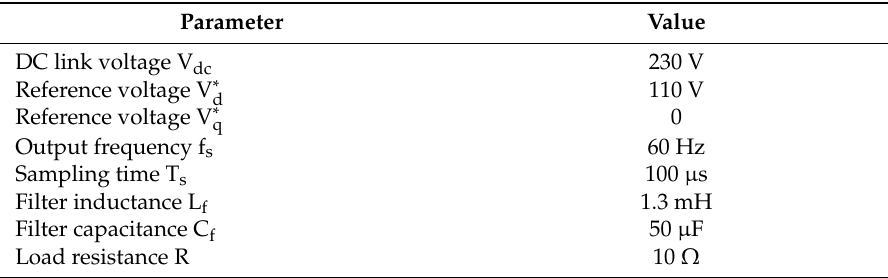
Table 1. Nominal system parameters.